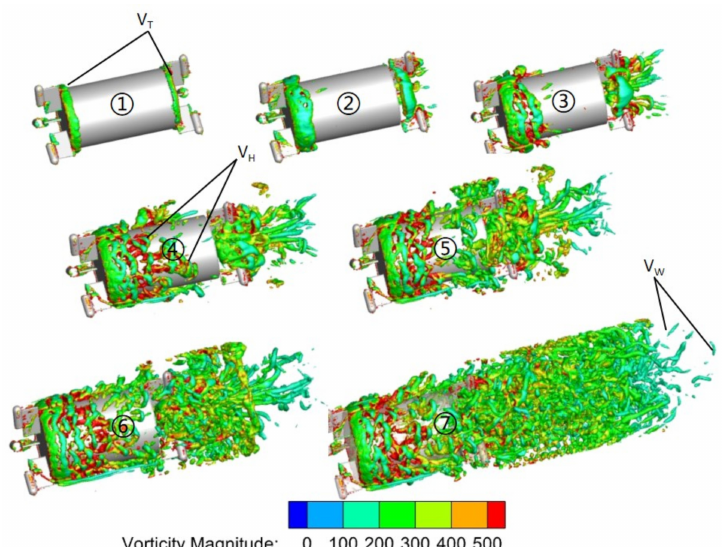
Figure 12. Three-dimensional instantaneous vortex structure isosurface around piped